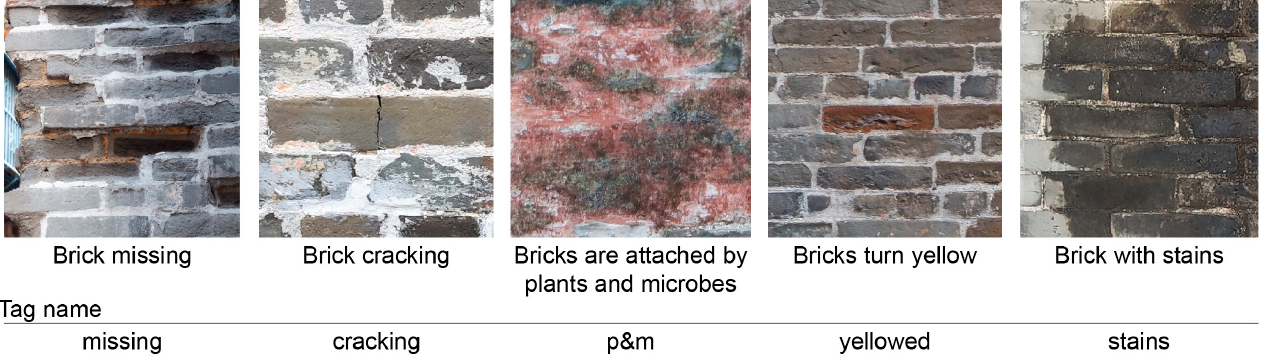
Figure 4. Brick damage types and tag names. (Image Source: the picture is taken by the author, and the text is drawn and added by the author).